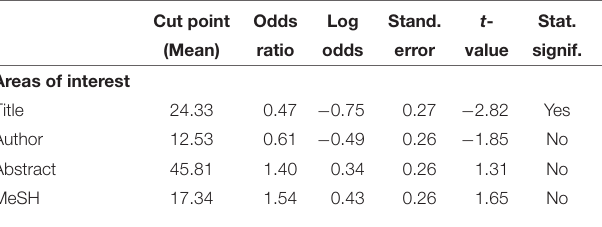
TABLE 6 | Summary of the relationship between number of pages viewed and gaze (N number of pages viewed = 256, N eye gaze = 256; statistical significance at 95%).